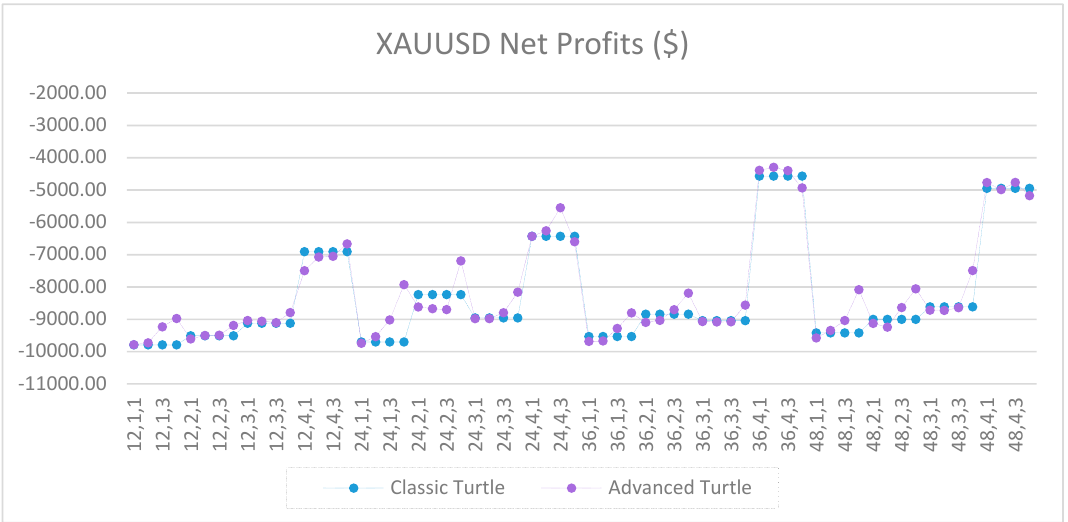
Figure A43. Net profits of XAUUSD between the classic and the advanced Turtle systems for every combination of N, X, Y for the slow parameters (80, 160).